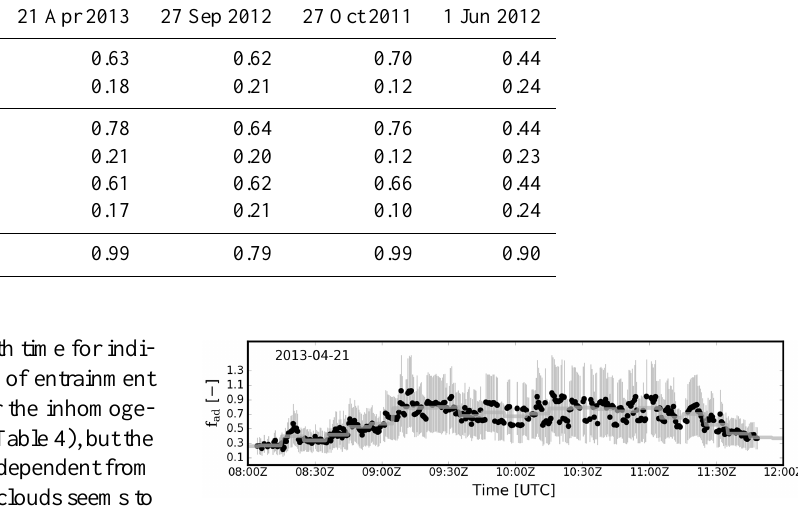
Figure 2. Time series of the adiabatic factor f ad for 21 April 2013. Black dots represent f ad derived using ground-based H and Q L . The gray line represents the 10min averaged and interpolated f ad neglecting superadiabatic